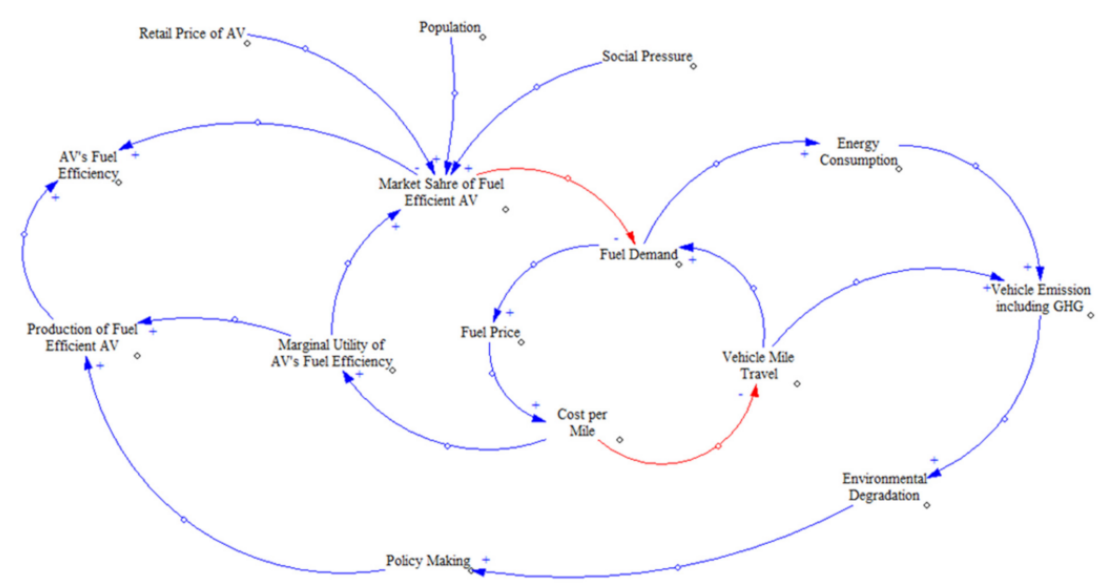
Figure 6. Causal Loop Diagram of the influence of fuel-efficient AVs on GHG emissions (inspired by